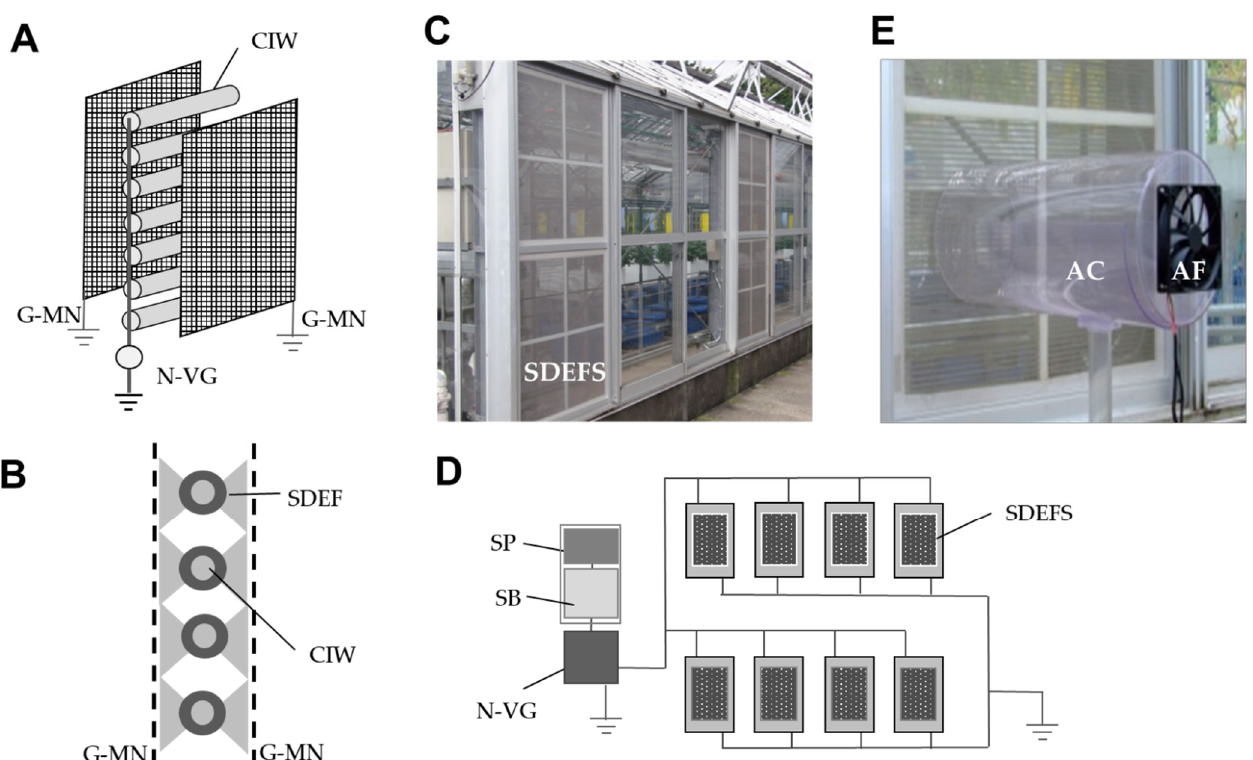
Figure 10. ( A , B ) Structure of a single-charged dipolar electric field screen (SD screen) ( A ) and its cross-sectional view ( B ). ( C ) SD screens installed on the lateral windows of a greenhouse. ( D ) An electric circuit to link the EF screens to a voltage generator operated by a solar panel and storage battery. ( E ) Acrylic cylinder with an axis fan for observing the behavior of insects reaching the net of the SD screen. G-MN, grounded metal net; CIW, charged insulated iron wire; N-VG, negative voltage generator; SD-EFS, single-charged dipolar electric field screen; SP, solar panel; SB, storage battery; AC, acrylic cylinder; AF, axis fan.